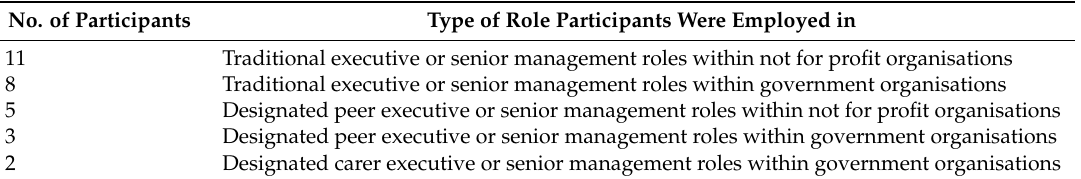
Table 1. Participant Roles and